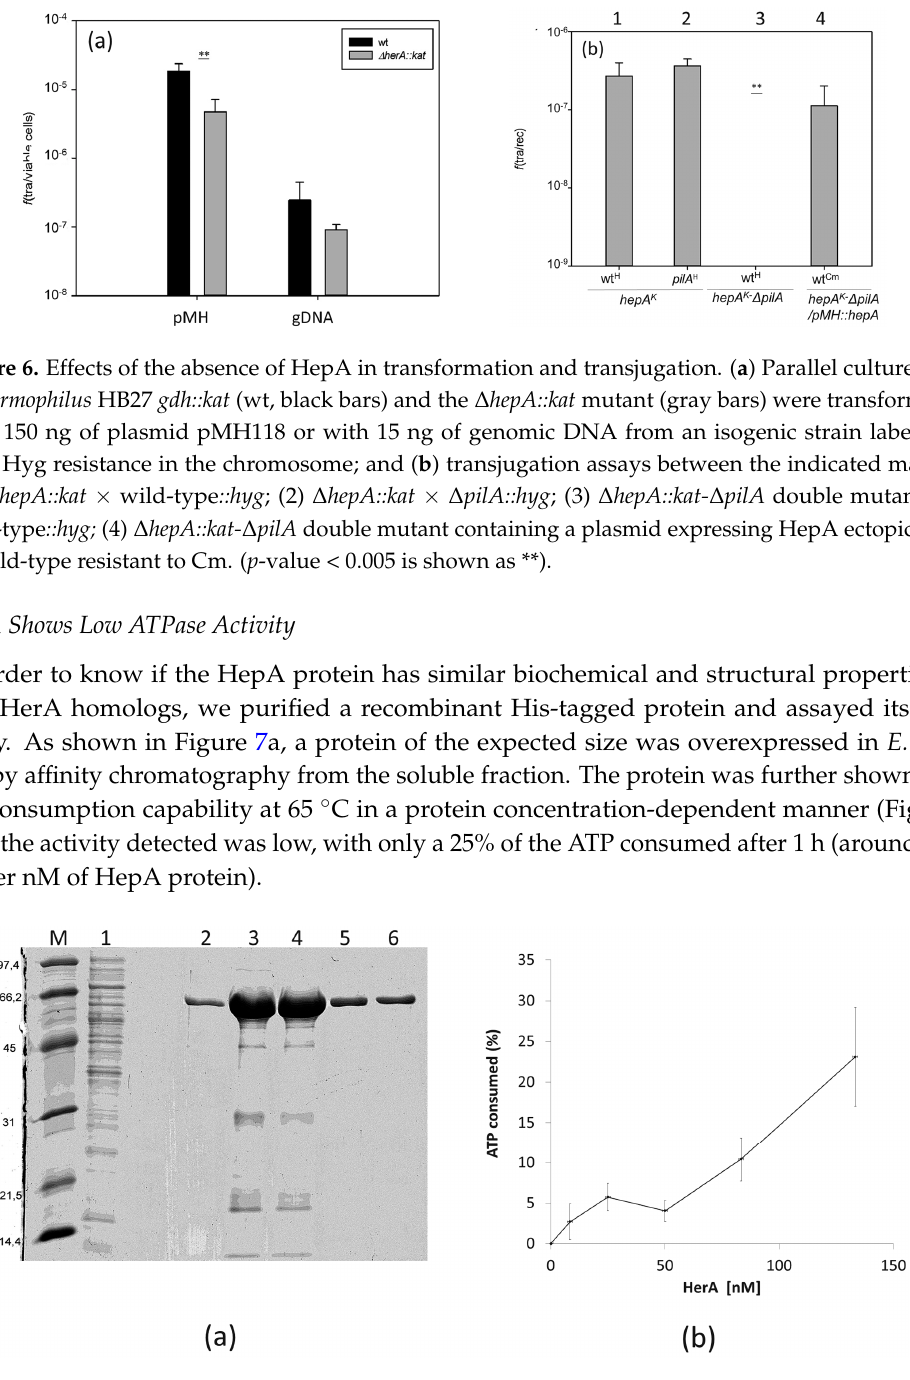
Figure 7. Purification and ATPase activity of HepA. ( a ) Coomassie blue-stained SDS-PAGE